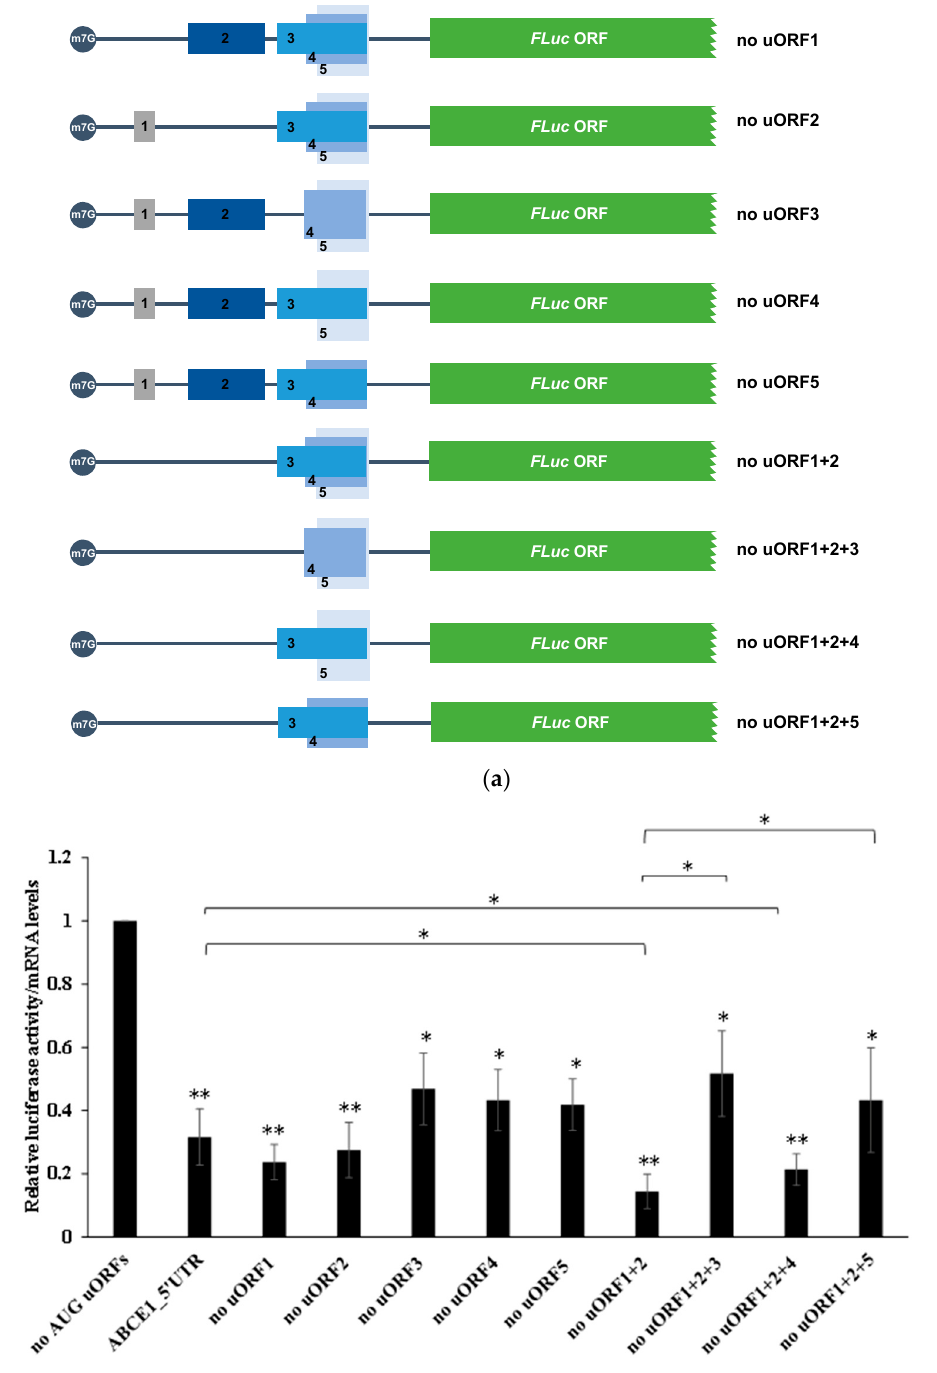
18 of 29 Figure 7. uORF1 and uORF5 present in the ABCE1 5 ′ -leader sequence have the potential to be efficiently recognized and translated by the ribosomes, allowing translation reinitiation to occur at the main AUG. ( a ) Schematic representation of the constructs where the Kozak sequence context of each uORF initiation codon was replaced by an optimal Kozak se- quence context (ACCATGG; indicated by the red triangle), obtaining the constructs Optimal_uAUG1, Optimal_uAUG2, Optimal_uAUG3, Optimal_uAUG4, and Optimal_uAUG5. The five non-AUG uORFs are present in these constructs but not represented in the figure to simplify the scheme. ( b ) HCT116 cells were transiently co-transfected with each one of the constructs described in ( a ), or ABCE1_5 ′ UTR, “no AUG uORFs”, or the constructs with only one functional AUG uORF (uORF1-5) already described in Figure 2a, and the pRL-TK plasmid. Expression of these constructs was analyzed as de- scribed in Figure 2b legend. The results are presented as mean ± SEM from at least three independent experiments. Stu- dent’s t-test was applied for statistical significance: p < 0.05 (*) and p < 0.01 (**). 3.4. ABCE1 uORF3 and uORF5 Are Competent Translational Repressors, Greatly Regulated by uORF1 and to a Less Extent by uORF2 Taking into account the complexity of the 5 ′ -leader sequence of ABCE1 mRNA in terms of uORFs and knowing the potential of each AUG uORF to be translated or leaky scanned, we next decided to investigate how the five ABCE1 AUG uORFs function when together in the native configuration, to regulate the expression of the main coding se- quence. With this aim in mind, we mutated the ABCE1 uAUGs in several possible combi-